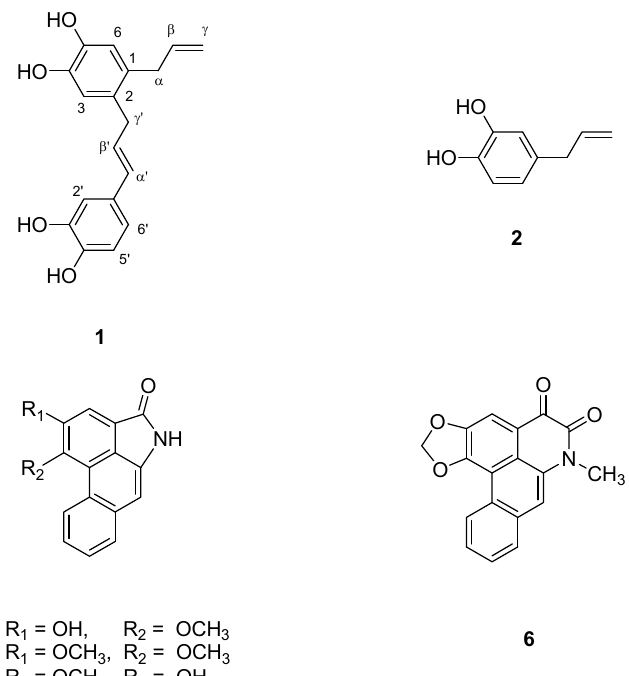
Figure 1. The chemical structures of compounds 1 – 6